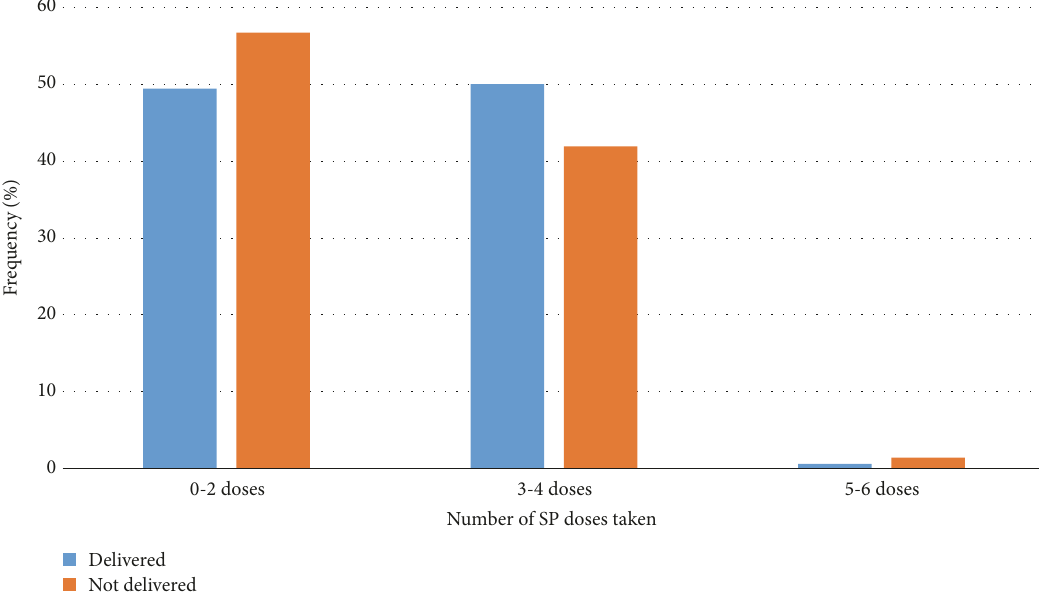
Figure 2: Doses of SP taken by mothers who had delivered and those who had not yet delivered.